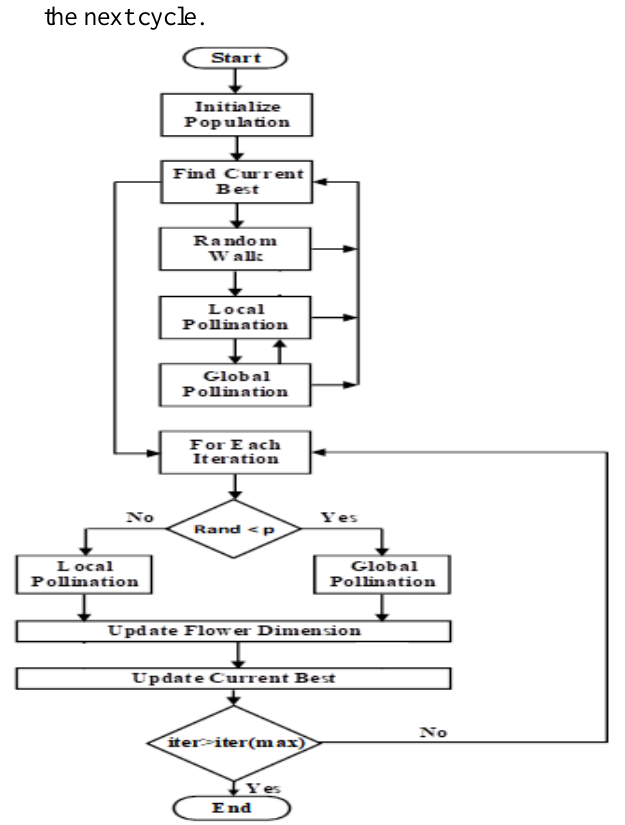
Fig. 3. Adaptive flower pollination